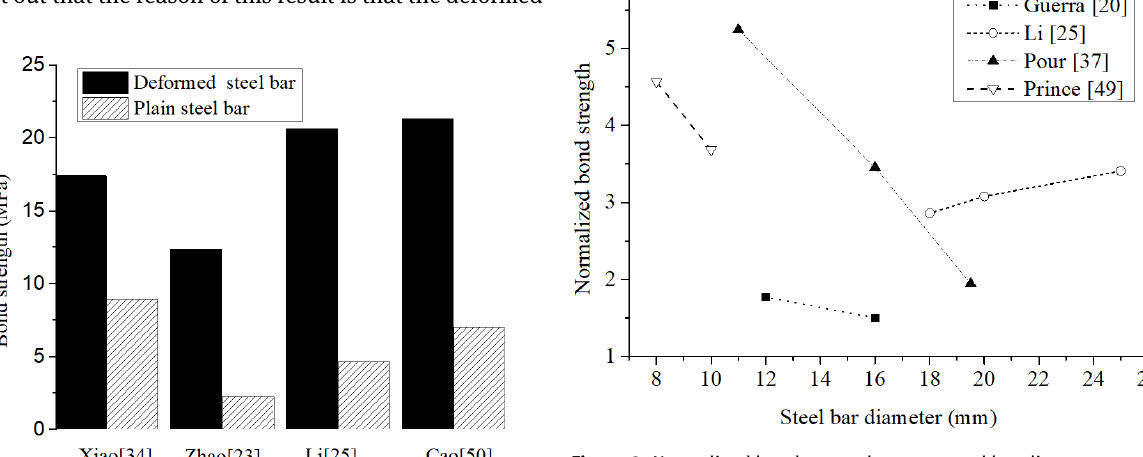
Figure 8: Normalized bond strength versus steel bar